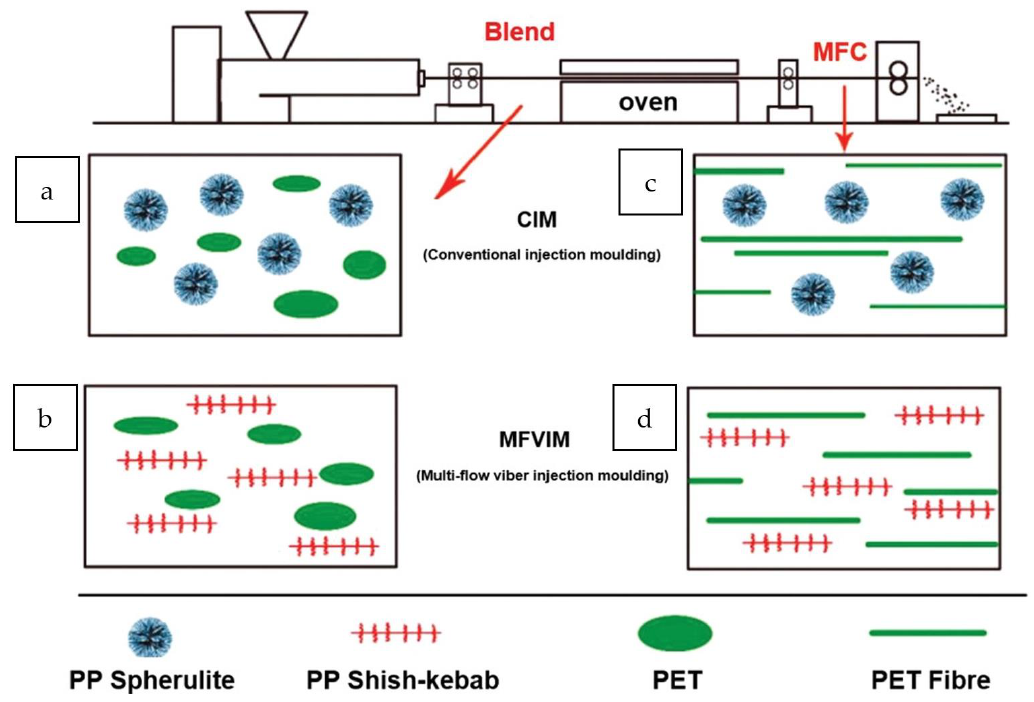
Figure 5. Global and EU waste management rates. Reprinted with permission from ref. [16].